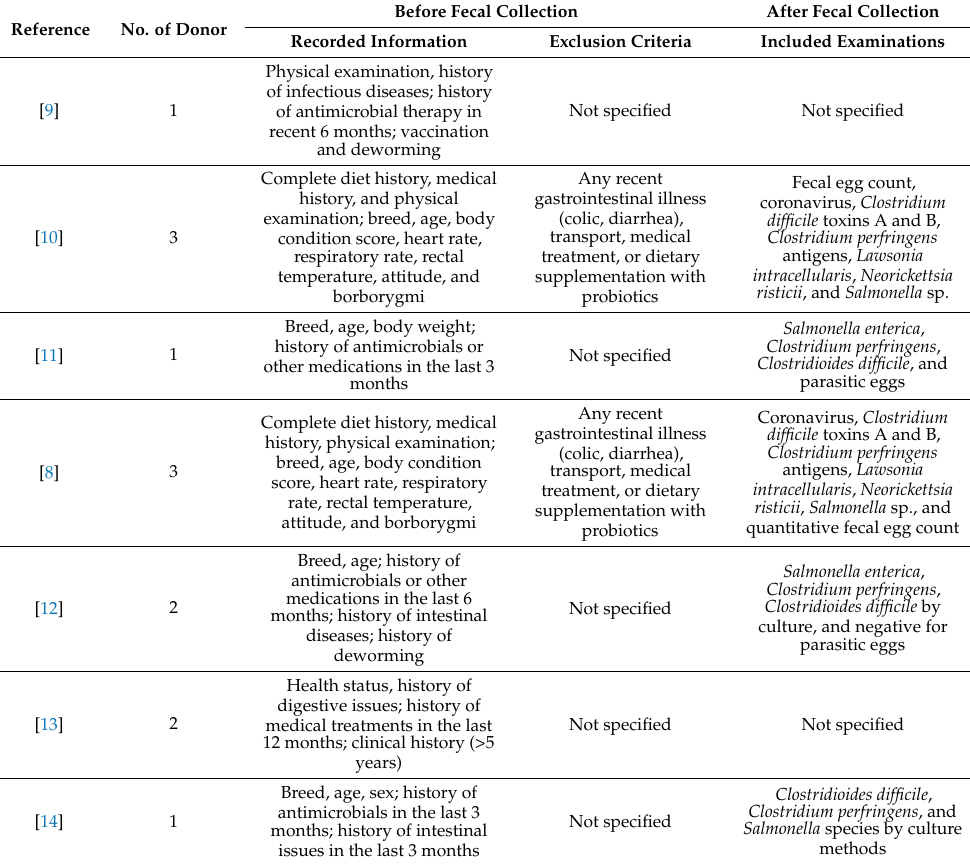
Table 2. Donor examinations before and after fecal